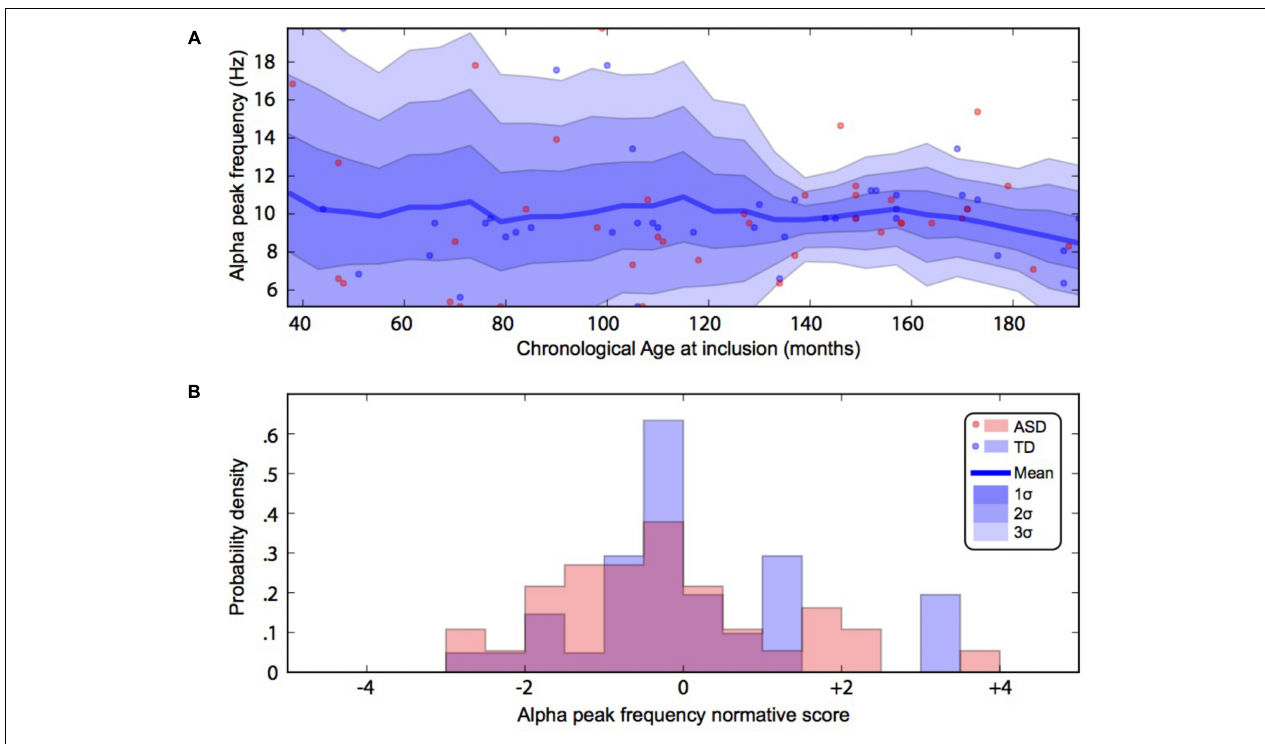
FIGURE 3 | Alpha waves normative modeling in patients and TD participants: effect of age heterogeneity on alpha frequency. (A) Shows the raw data with the non-parametric normative model overlaid in blue. (B) Summarises the normative scores with an histogram. ASD, autism spectrum disorder; TD, typically developing